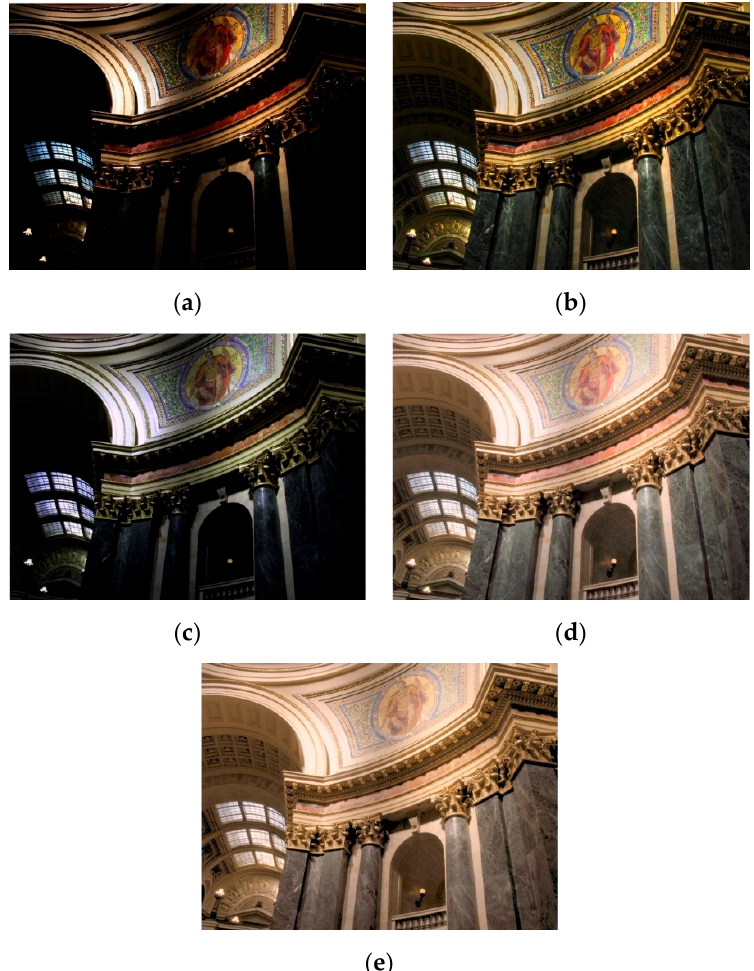
Figure 6. “aligned_00260” images with ( a ) an original HDRI, and resulting images of ( b ) iCAM06, ( c ) Reinhard’s method, ( d ) Choi’s method, and ( e ) the proposed method.